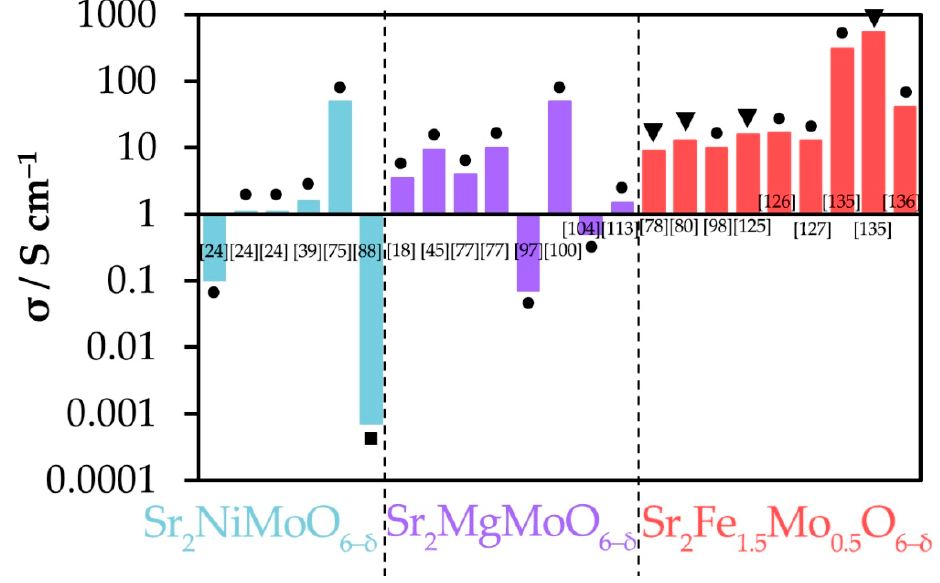
Figure A2. Total conductivity of Sr 2 MMoO 6– δ materials in reducing ( ● ), pO 2 -intermediate ( ■ ) and oxidizing ( ▼ ) atmospheres. Visualization of Tables 3, 5 and 6.